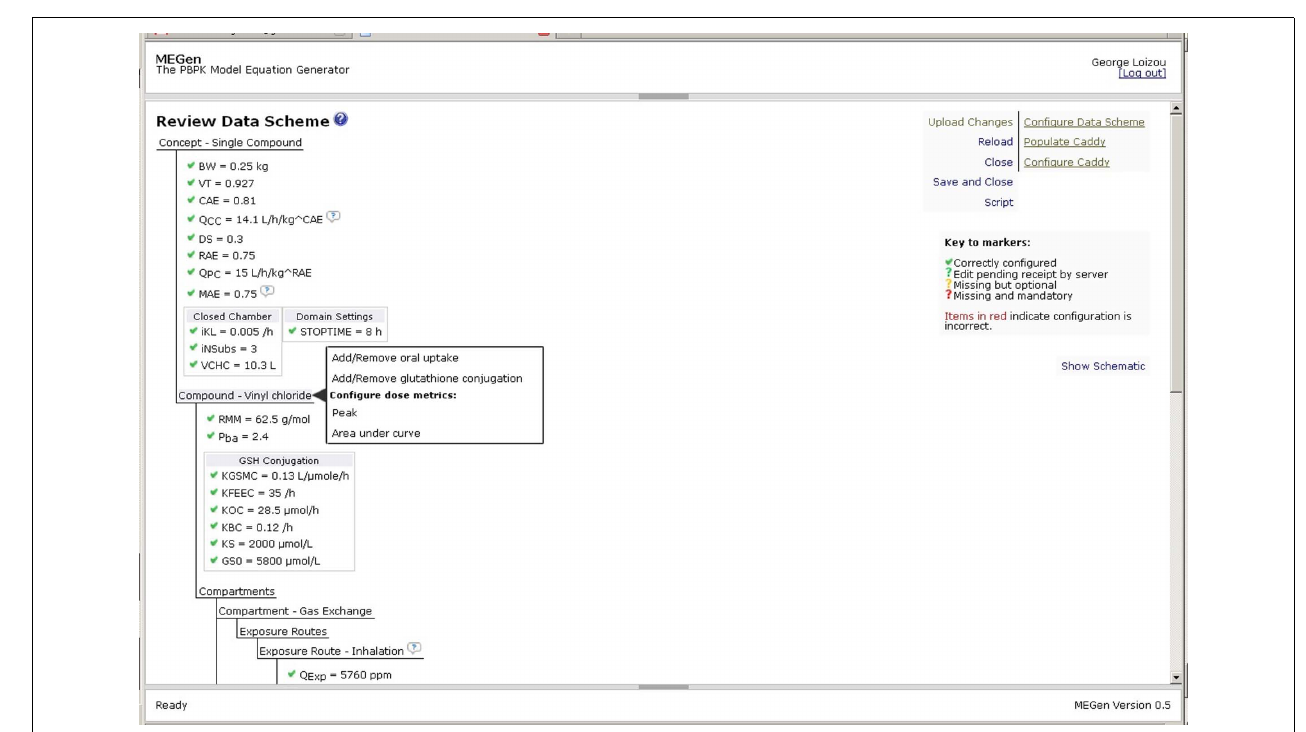
FIGURE 9 | Model review